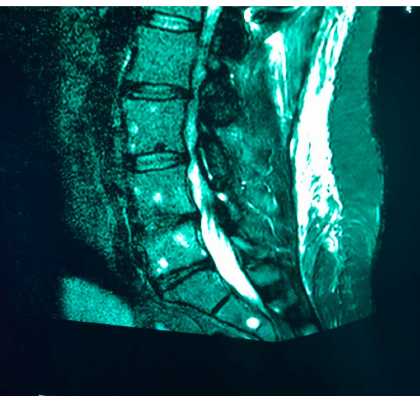
Figure 1: MRI shows multiple, variable-sized, well-defined round lesions.